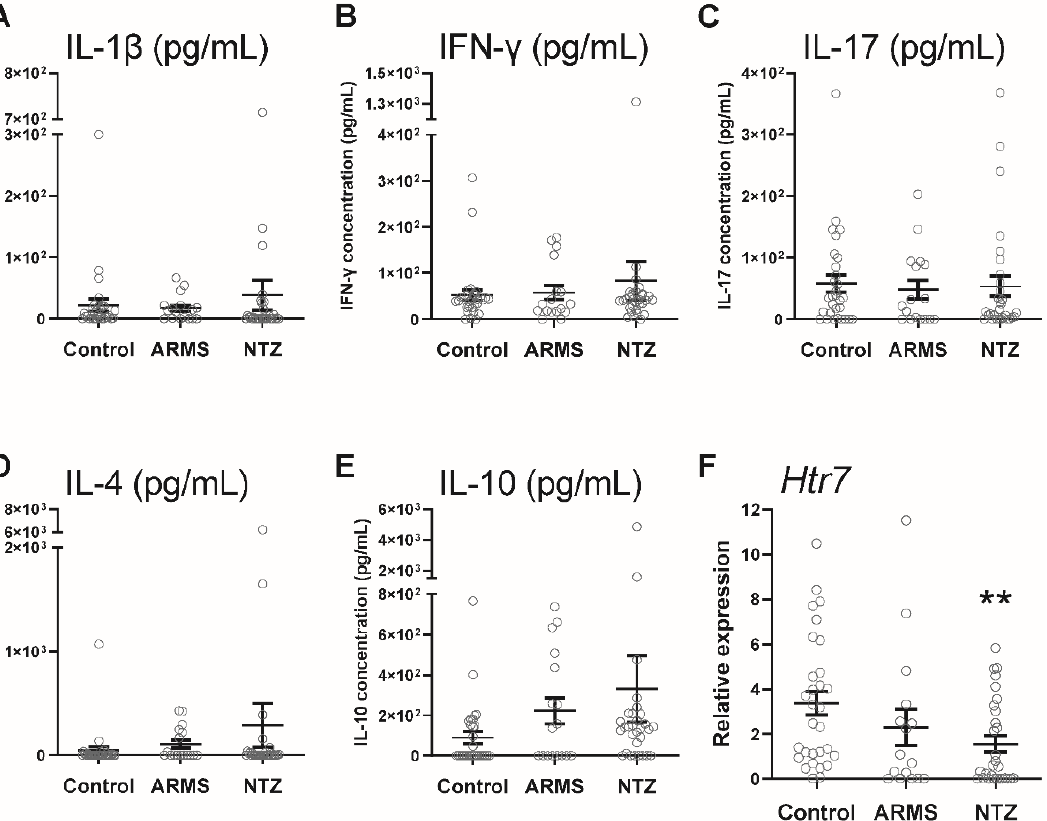
Figure 3. Plasma immunological context and Htr7 gene expression in PBMCs from control, ARMS, and NTZ patients. Cytokines assays: IL-1 β ( A ), IFN- γ ( B ), IL-17 ( C ), IL-4 ( D ), and IL-10 ( E ) from plasma samples of control, ARMS, and NTZ patients. Htr7 was analyzed by RT-qPCR. The relative expression of Htr7 mRNA levels, normalized to Gapdh and Hprt1 of control subjects, is shown ( F ). Results are given as mean ± SEM. ** p < 0.01 compared with control.